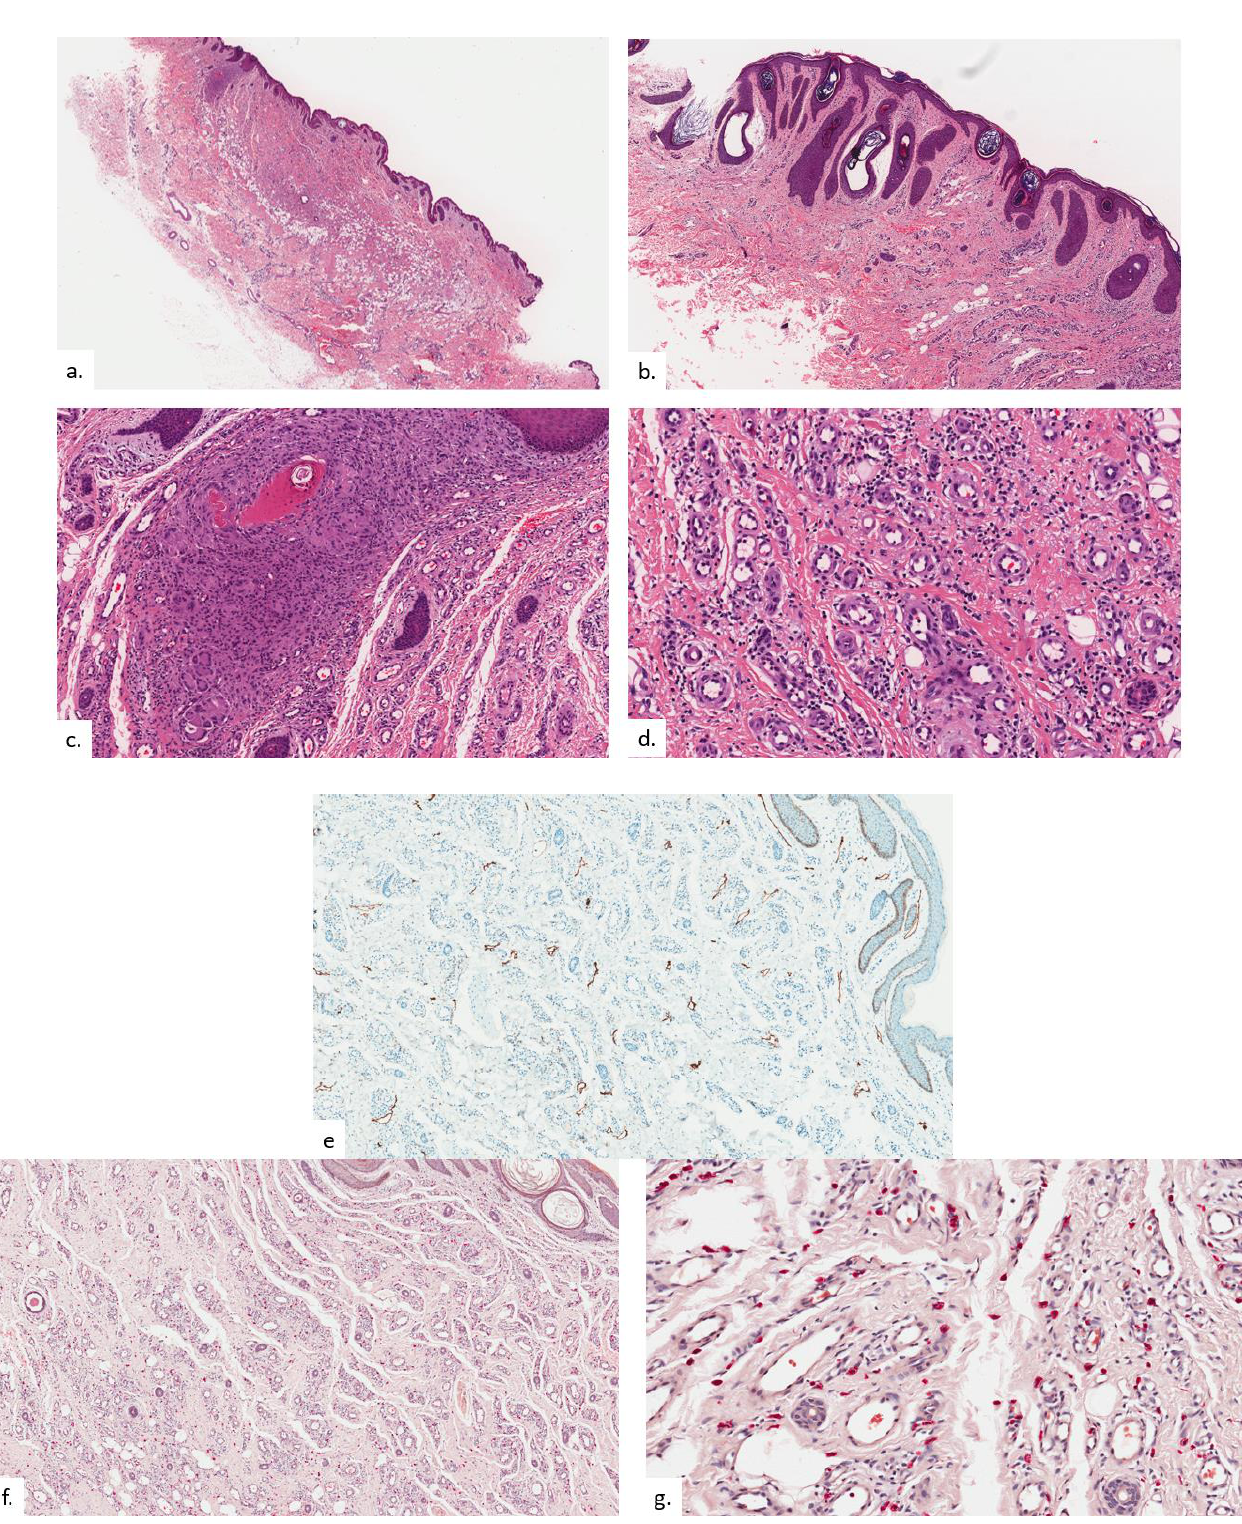
Figure 7. Patient 4. ( a ) There was a small tender 0.5 cm rounded dermal centered nodule over the left buttock. The surrounding skin showed hyperpigmentation and lichenification; ( b ) the nodule and surrounding lichenification were over the left gluteal fold, overlying the ischial tuberosity, at the base of the sitter’s triangle (red tr iangle).